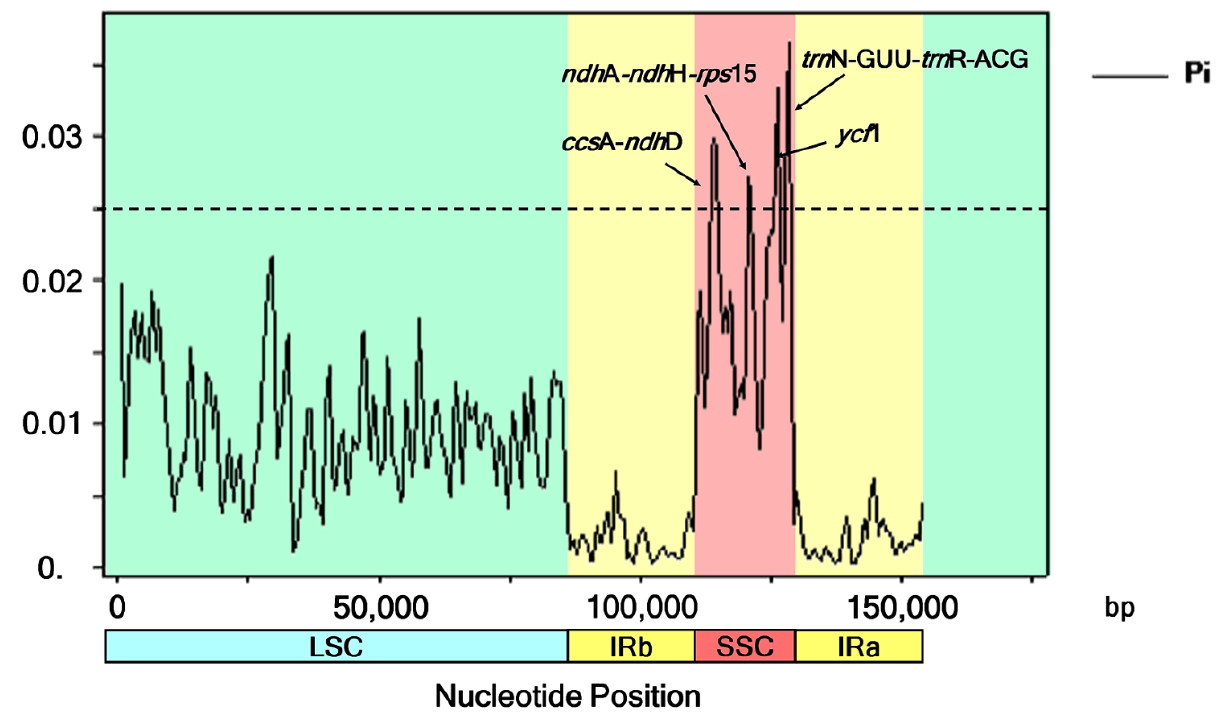
Figure 5. Nucleotide variability values were compared between the six Barleria chloroplast sequences using a sliding window analysis (window length is 1000 bp; step size is 500 bp). The x-axis and y-axis indicate the position of the midpoint of the nucleotide diversity of each window.